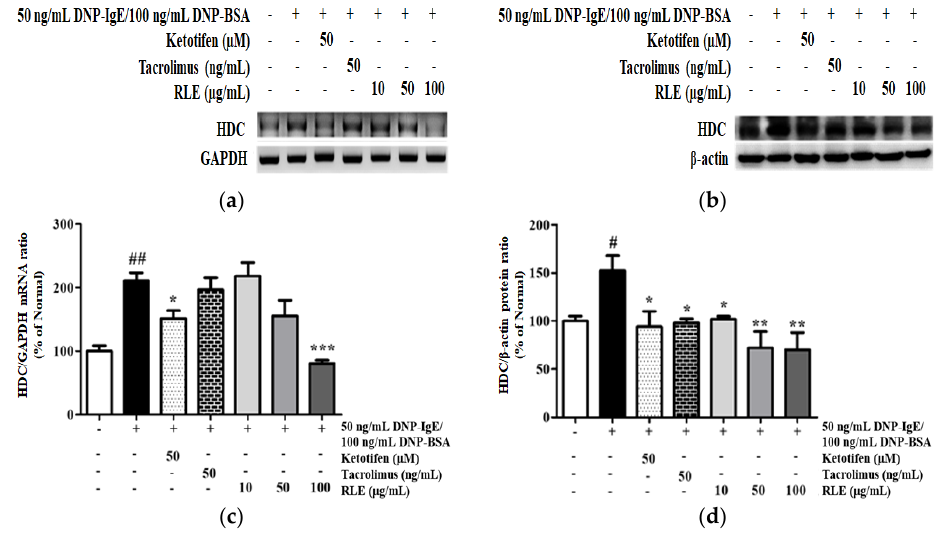
Figure 8. The effects of R. davurica Pall. leaf extract on the mRNA and protein levels of histidine decarboxylase (HDC) isolated from RBL − 2H3 cells. The mRNA and protein levels were determined by RT ‐ PCR ( a ) and western blot ( b ). The band intensities were quantified by densitometry, normalized to the HDC level of mRNA ( c ) and protein ( d ) calculated as the percentage of the non ‐ treated group. Data are presented as the mean ± SD. # and * indicate significant differences between the non ‐ treated cells and DNP ‐ IgE/BSA ‐ sensitized groups, respectively. # and ## p < 0.05 and 0.01 vs. the non ‐ treated group. *, **and *** p < 0.05, 0.01, and 0.001 vs. the DNP ‐ IgE/BSA ‐ sensitized control, respectively.